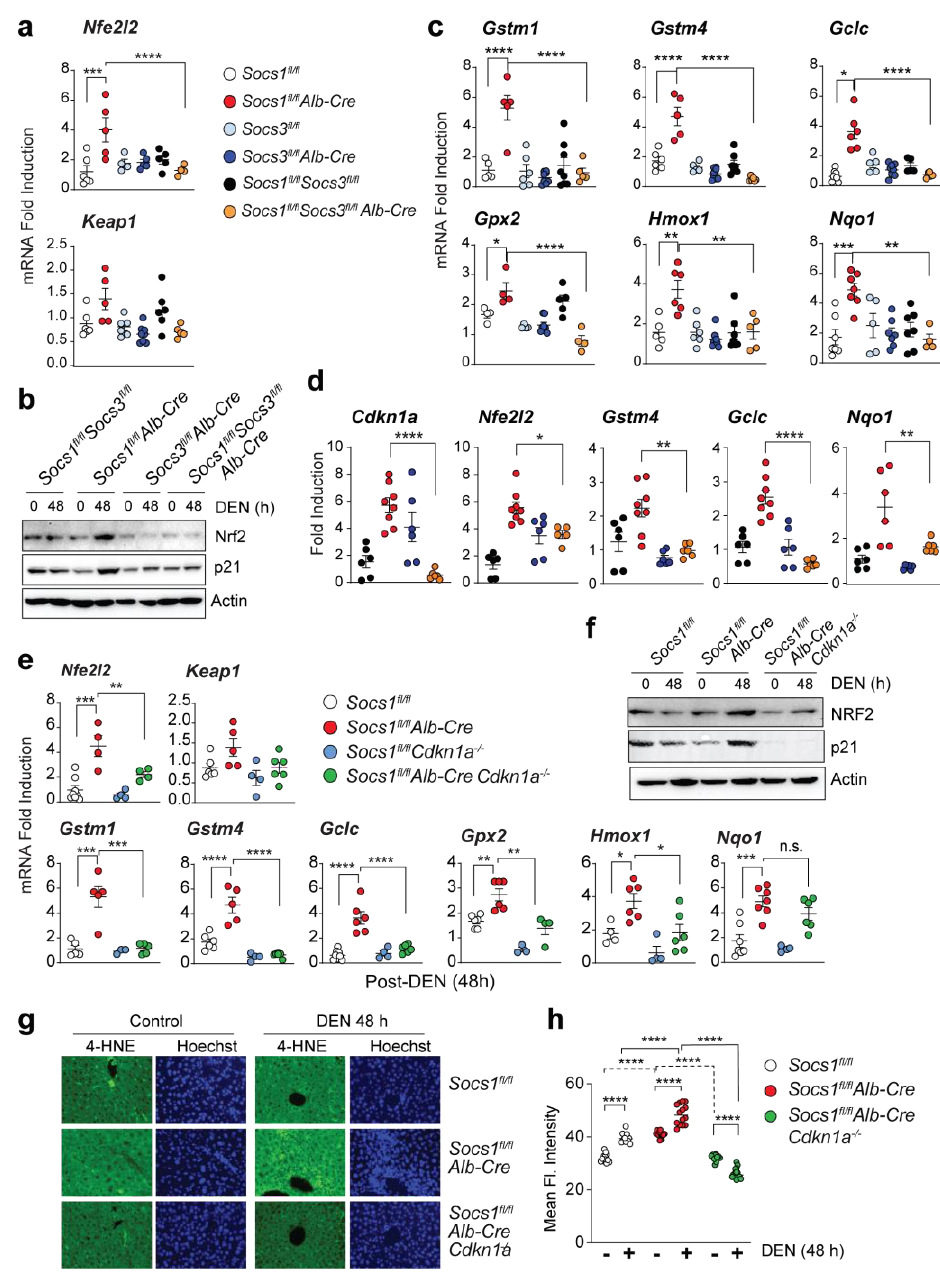
Figure 3. SOCS1 deficiency upregulates NRF2 and its target genes in a SOCS3 and CDKN1A- dependent manner. ( a , b ) Induction of the Nfe2l2 gene ( a ) and NRF2 protein ( b ) in the liver tissues of mice lacking SOCS1, SOCS3, or both in hepatocytes 48 h after DEN treatment. Cumulative data from 3 – 8 mice/group are shown in ( a ). For ( b ), representative data from more than two experiments are shown. ( c ) Induction of NRF2 target genes in mice lacking SOCS1, SOCS3, or both in hepatocytes 48 h after DEN treatment (n = 3–8 mice per group). ( d ) Expression of Cdkn1a, Nfe2l2, and NRF2 target genes in microscopically dissected DEN-induced HCC tumor nodules resected from the indicated genotypes of mice (n = 5–8 mice/group). ( e ) DEN-induced Nfe2l2 and NRF2 target gene expression in SOCS1-deficient mice lacking CDKN1A. Gene expression data for Socs1 fl/fl and Socs1 fl/fl Alb-Cre are duplicated from ( a , c ) for comparison. ( f ) Immunoblot analysis of NRF2, p21, and actin in the livers of DEN-treated mice of the indicated genotypes (n > 3). ( g ) 4-HNE staining for lipid peroxidation